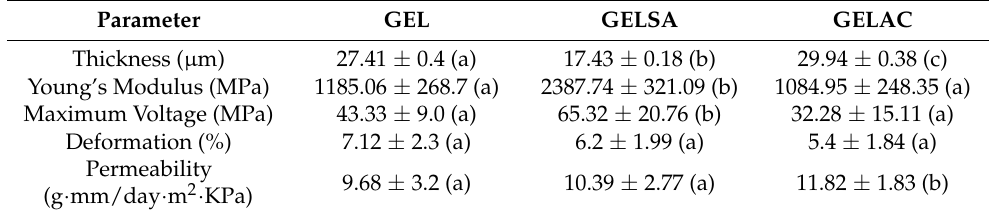
Table 4. Properties of GEL, GELSA, and GELAC biomembranes. Different letters on the same line represent significantly different values ( p <